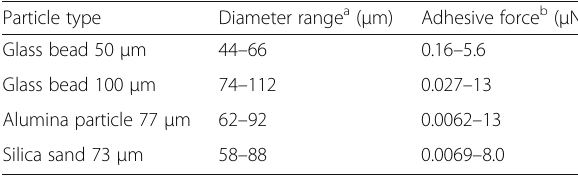
Table 2 Range of measured adhesive force between each particle and a Petri